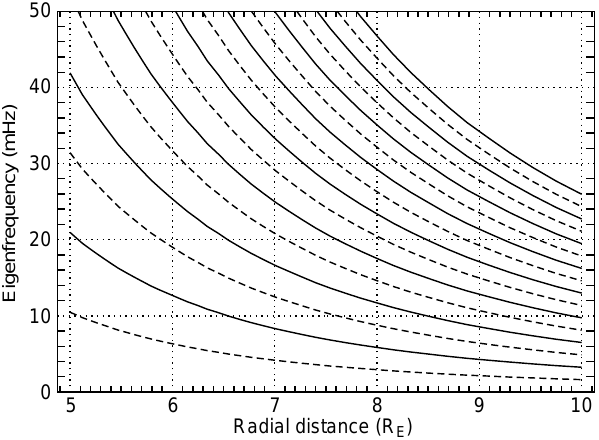
Fig. 7. Eigenperiods of the first eight quarter ( dashed lines ) and half ( solid lines )